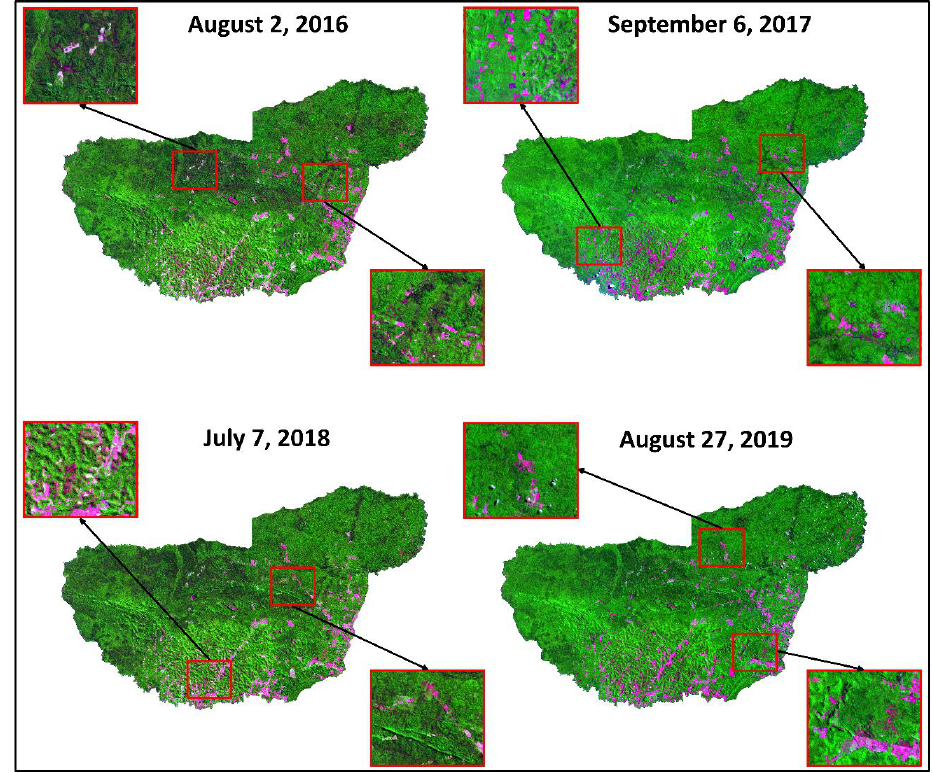
Figure 6. Illustration exemplifying the intrinsic relationship between fire and the deforestation process in the Apyterewa Indigenous Land on four selected dates between 2016 and 2019. The red boxes show in detail different burned areas within the indigenous land (pastures, agricultural fields and forests). These features appear dark in the satellite images. The false-color composites (R7G5B4) are just shown as illustrations and were not used for any processing for mapping land cover changes in the study area. These composites were obtained through operational land imager (OLI)/Landsat-8 images from 2 August 2016, 6 September 2017, 7 July 2018 and 27 August 2019.